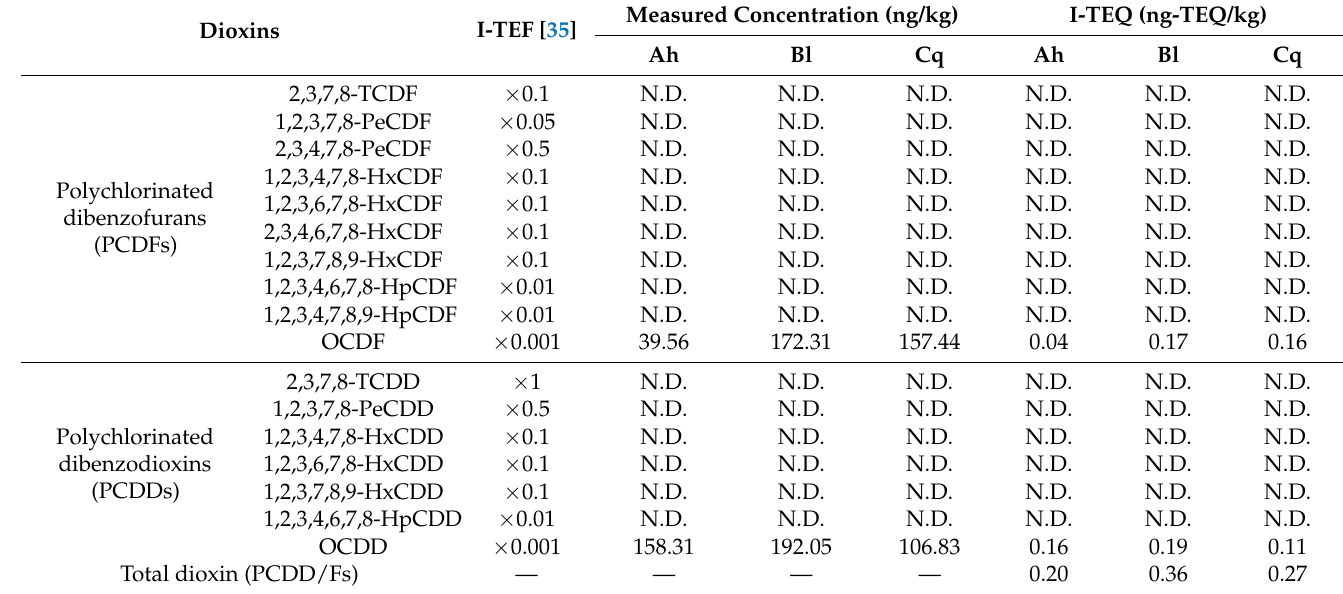
Table 4. Dioxin content in wet sludge of Ah, Bl, and